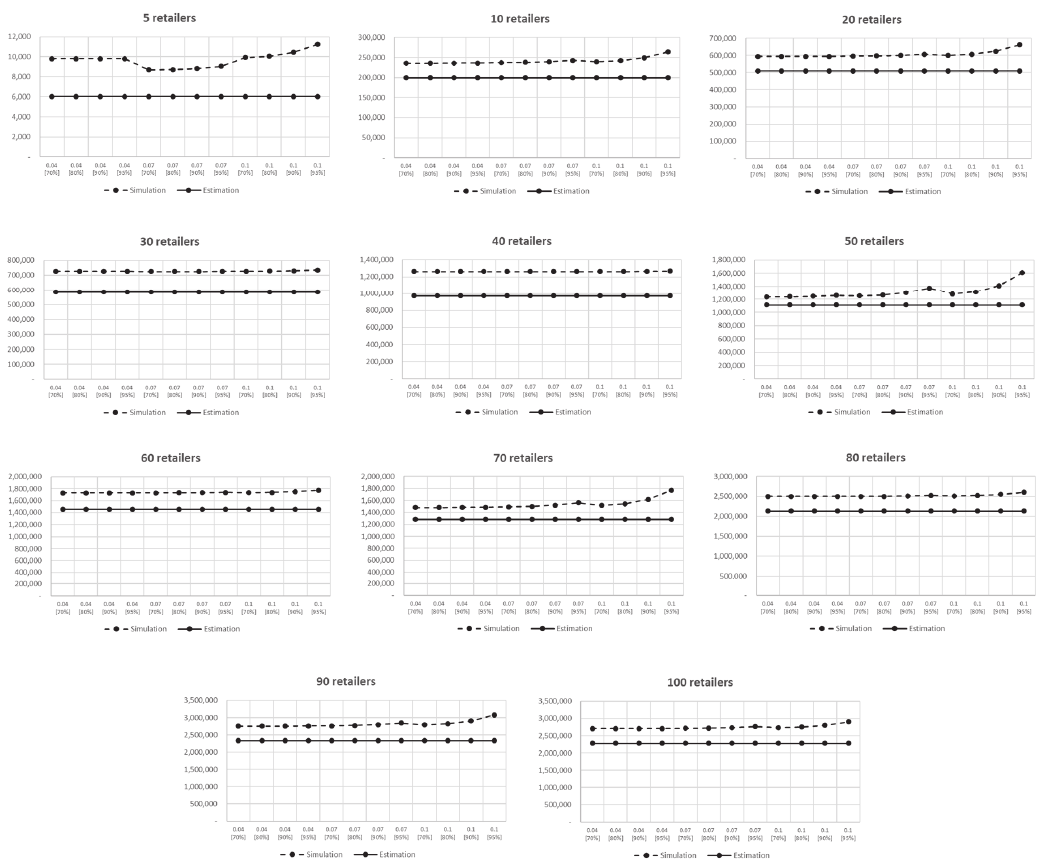
Fig. 4 . Estimated and simulated average costs for each